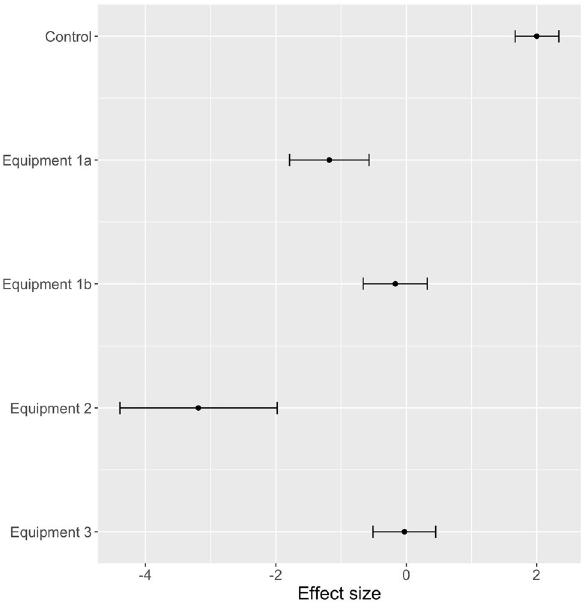
Figure 10. Effect size (estimate and 95% confidence interval of generalised linear mixed models) for the hygiene equipment tested across all soil and moisture types: Control = no hygiene; Equipment 1 = handheld brush + disinfectant (a = 70% methylated spirits, b = 2% BAC); Equipment 2 = Fixed boot brush and footbath with 10% BAC; Equipment 3 = hygiene station with fixed brush and 10% BAC spray; 95% confidence intervals that do not overlap can be considered significantly different. Positive effect values indicated that treated boots retained P. cinnamomi .